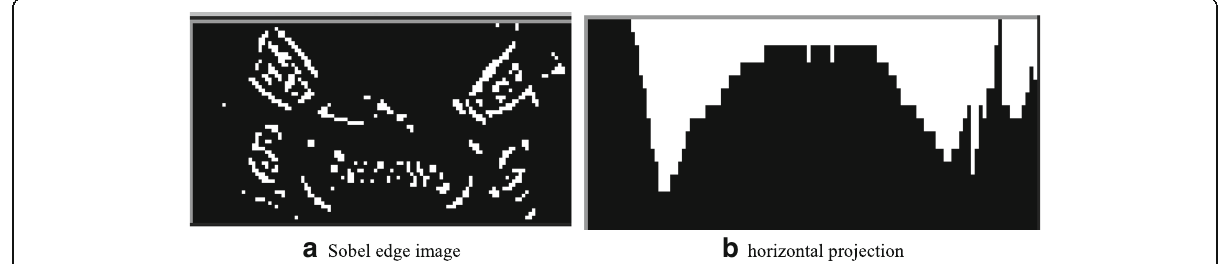
Fig. 4 Sobel edge image and horizontal projection extracted from the detected vehicle as shown in Fig. 3. a Sobel edge image. b Horizontal